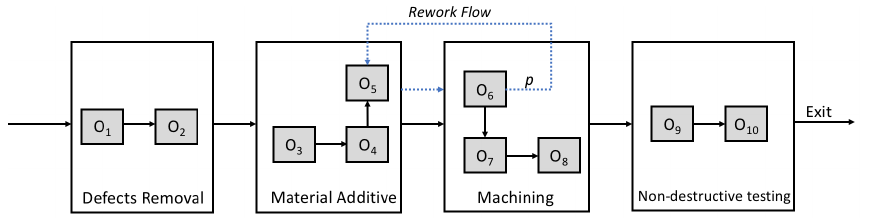
Figure 5. Repairing process example for a batch with